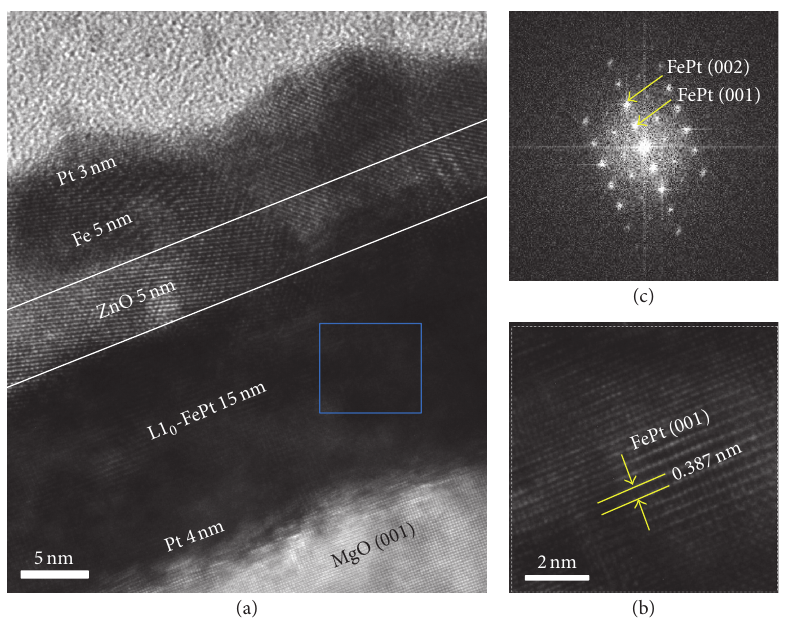
Figure 2: TEM analysis of the Pt(4)/FePt(15)/ZnO(5)/Fe(5)/Pt(3) multilayers. (a) The cross section TEM image. (b) The HRTEM image. (c) Its corresponding FFT